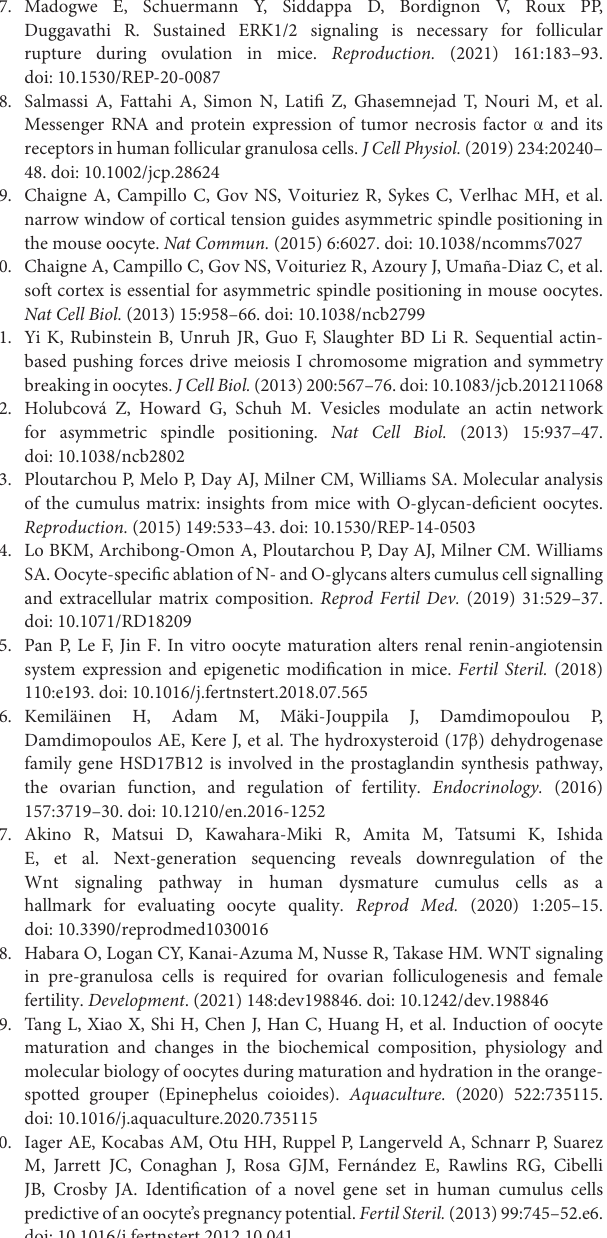
Supplementary Figure 1 | Q-Q graph of GSE144664 dataset. Supplementary Table 1 | Genes with hypomethylated CpG sites. Supplementary Table 2 | Genes with hypermethylated CpG sites. Supplementary Table 3 | Differentially expressed genes with p -value in GSE113239 dataset. Supplementary Table 4 | Enriched KEGG pathway and annotated genes in GSE113239